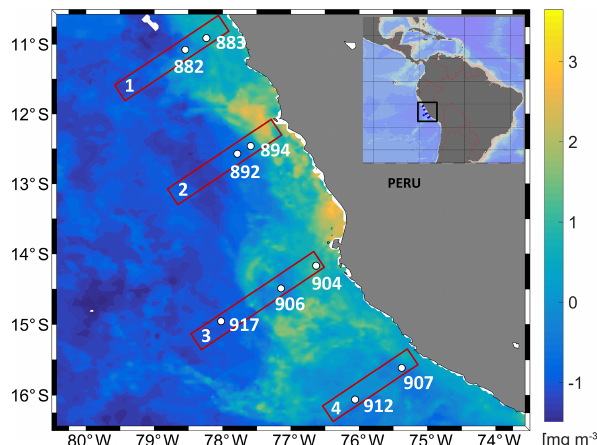
Figure 1. Study area with the distribution of near-surface chloro- phyll concentrations (monthly averaged for June 2017) from MODIS obtained from the NASA Ocean Color Web site at 4km resolution. Study site showing transect and station numbers in the eastern tropical South Pacific during cruise